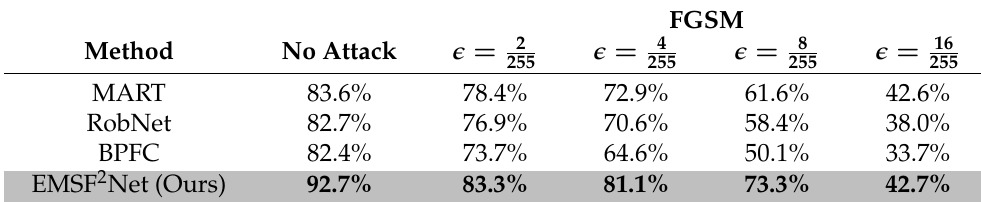
Table 2. Clean and robust accuracies under the FGSM attack on CIFAR-10 dataset. The lightgray row represents the results of the proposed method, and the bold results represent the best results.